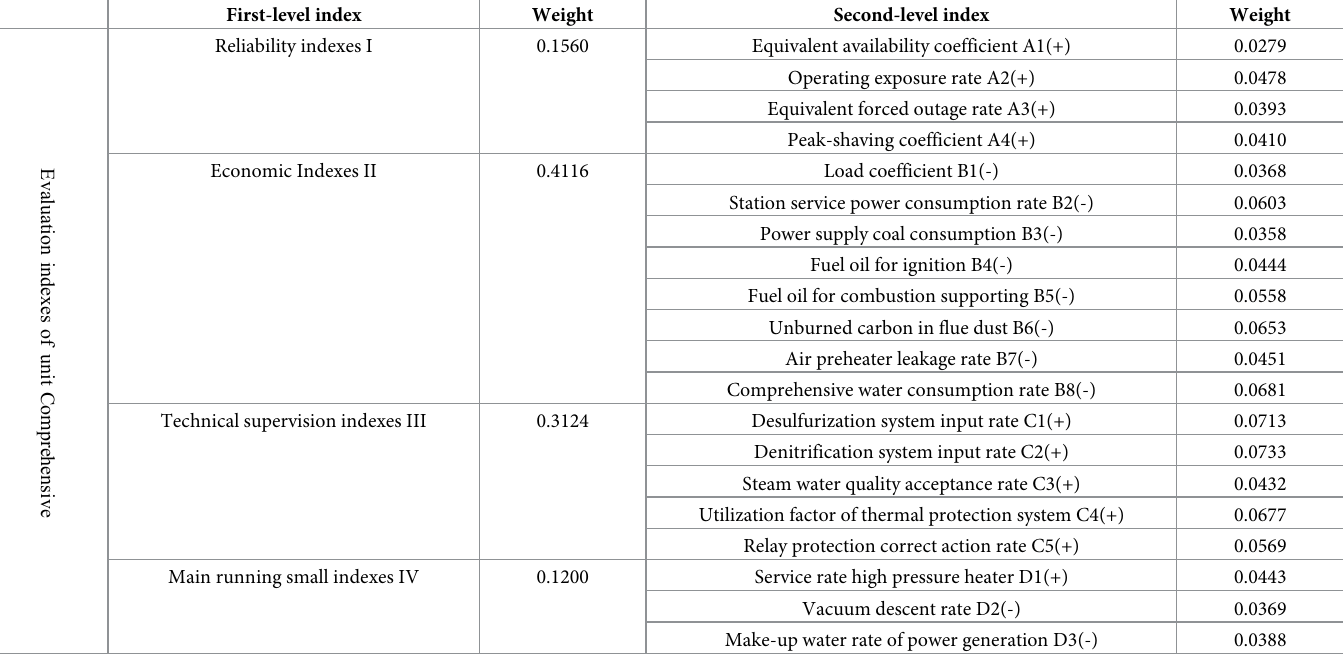
Table 1. The weight of TPGU comprehensive evaluation